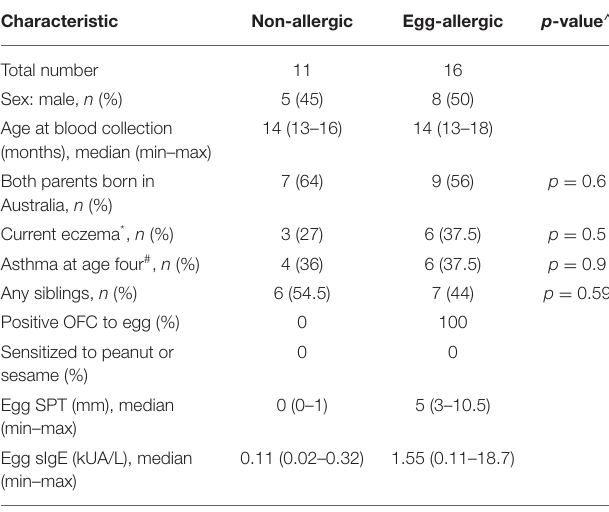
TABLE 1 | Demographics and clinical characteristics of selected